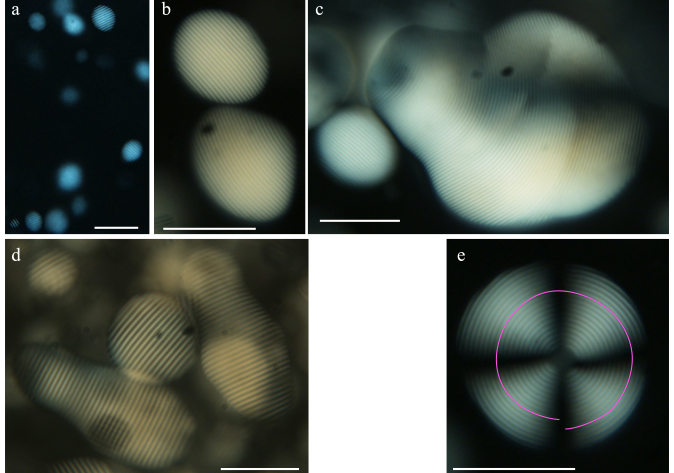
Figure 8. Representative polarizing microscopy micrographs (crossed polarizers) of tactoids of cholesteric CNC suspensions, soon after ’birth’ ( a ) and later in the growth process ( b – d ), eventually reaching sizes where radial helix orientation occurs ( e ). Even in the smallest tactoids in ( a ), the helix has probably developed, although the focus may render it difficult to see (see discussion in main text). In the last panel one ’dark ring’ has been emphasized, to highlight the non-closing spiral-like character of the stripes in the ’fingerprint’ texture decorating the tactoids. The distance between two consecutive stripes is p /2 (see Section 7.1). Scale bars correspond to 50 µ